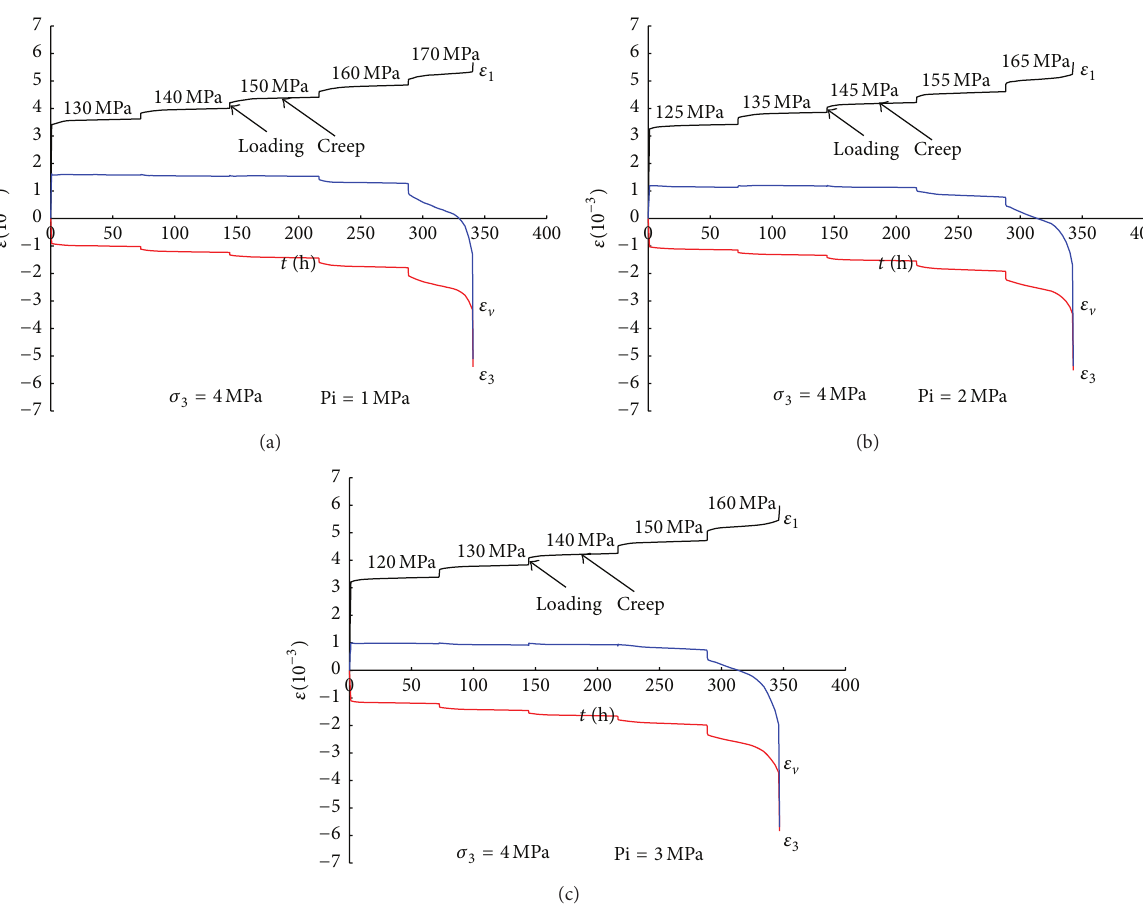
20 h, 30 h, 40 h, and 50 h in each stress level are determined as the time parameter in the isochronous stress-strain